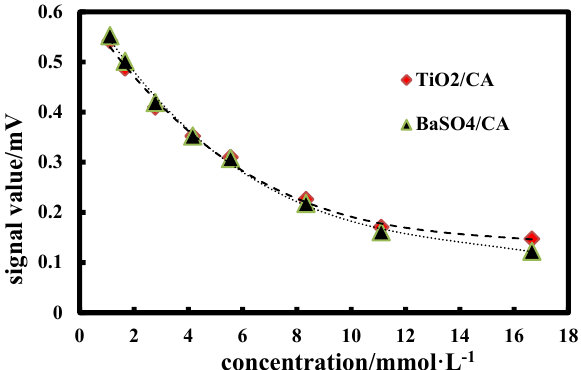
Figure 9. Standard curves of glucose (GLU)-TiO 2 / CA and GLU-BaSO 4 / CA detection chips at di ff erent GLU concentrations.